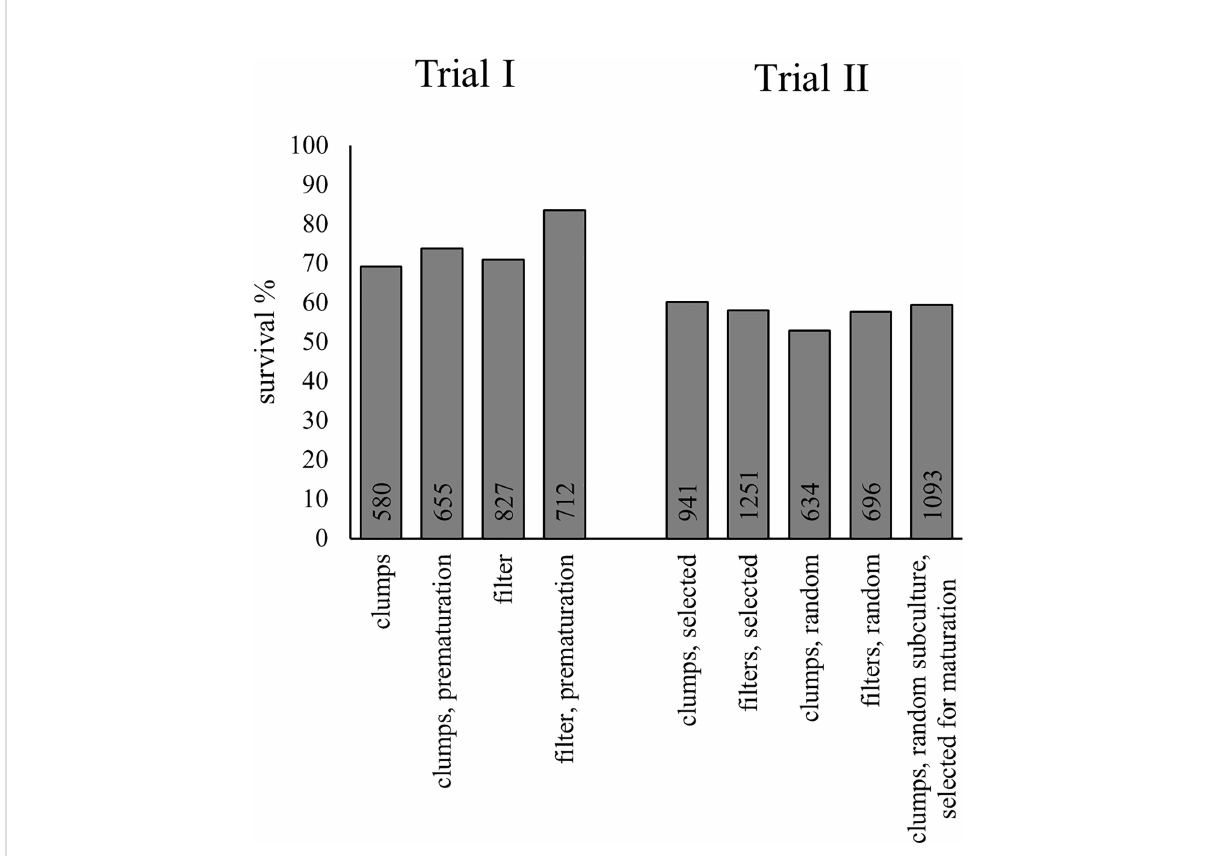
FIGURE 4 Greenhouse survival of embryos from Trials I and II. The survival was evaluated from photographs 41 days after transplantation. The number of embryos transplanted from each treatment is presented inside the base of the